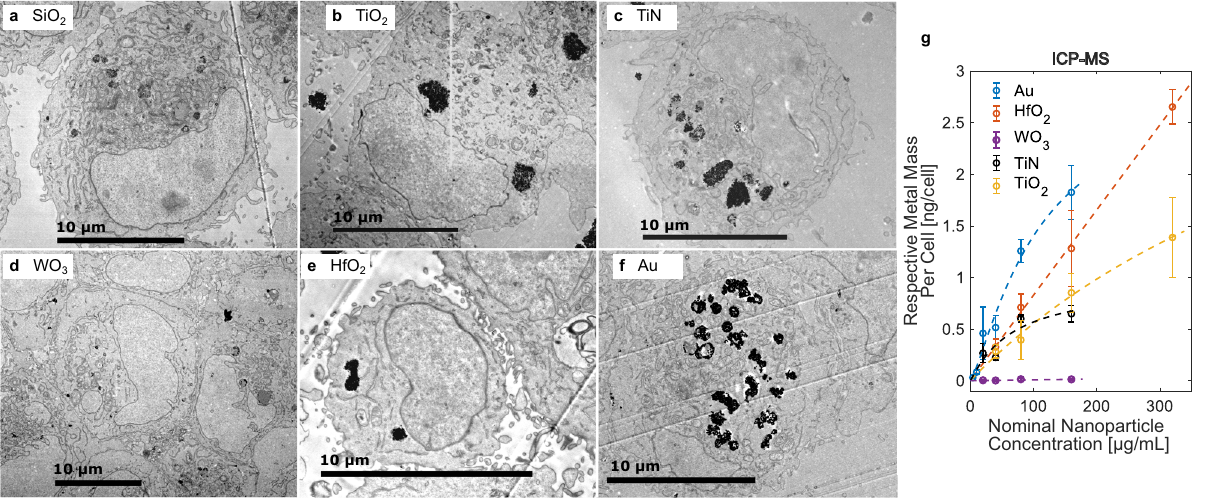
Fig. 2 Cellular uptake of nanoparticles. Scanning transmission electron (STEM) micrographs of HT1080 cells exposed to 80 µ g/mL SiO 2 ( a ), TiO 2 ( b ), TiN ( c ), WO 3 ( d ), HfO 2 ( e ), and Au ( f ) nanoparticles for 24 h. Intracellular and cell-associated metal mass normalized to cell number as quanti fi ed by ICP-MS ( g ). Data in g expressed as mean ± SD from n = 4 biological repeats per data point examined over 2 independent ICP